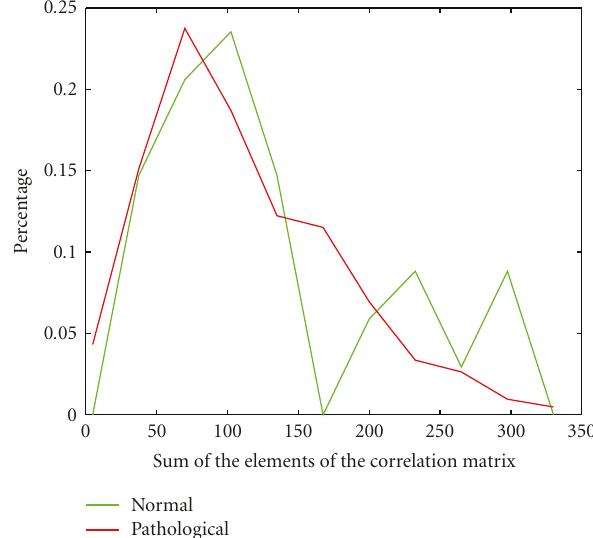
Figure 7: Distribution of the sum of the elements of the correlation matrix for normal samples (green) and pathological samples (red) included in the training set.